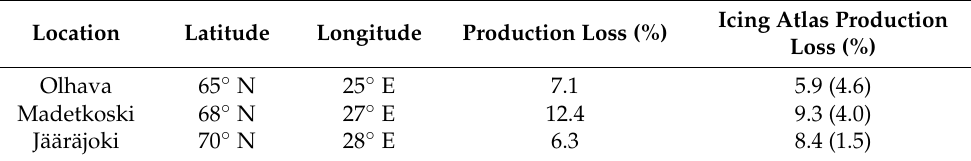
Table 4. Icing model comparison between the developed model and the Finnish Icing